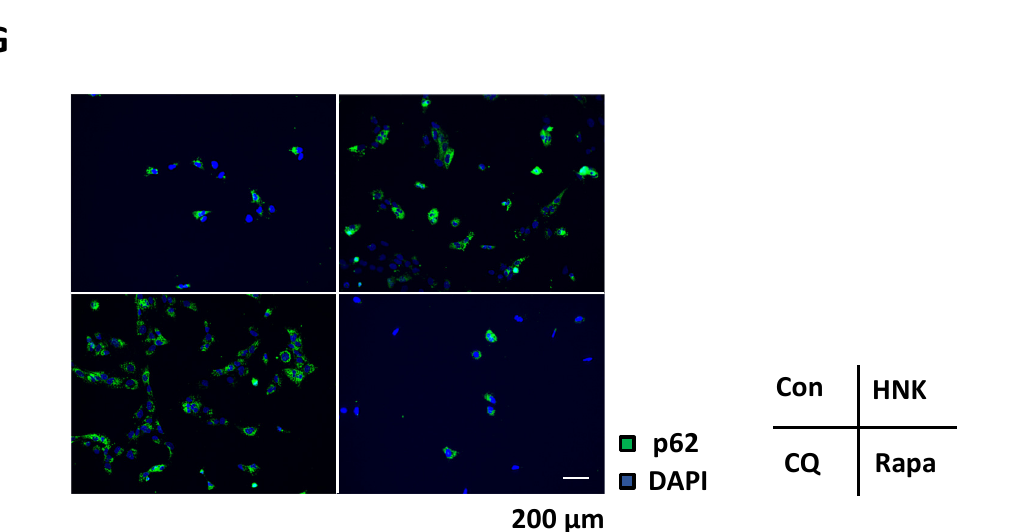
Figure 5. Effects of HNK in suppressing LX-2 activation related to autophagy pathway. ( A – F ) Immunoblot of markers related to autophagy (LC3-I, -II) in LX-2 cells incubated with the noted concentrations of HNK with or without 10 μ M chloroquine phosphate (CQ) or 2.5 μ M rapamycin (Rapa). GAPDH was used as a loading control. Numbers on the right indicate the noted molecular weights (kDa). The ratio of LC3-II to LC3-I (LC3-II/LC3-I) in each group is shown as fold change with reference to the vehicle-treated group. ( G ) Immunofluorescence analysis (IF) of p62 protein (green) in LX-2 cells counterstained with DAPI (blue) after 12 h incubations with DMSO (negative control), 20 μ M HNK, 10 μ M CQ (without HNK), or 2.5 μ M Rapa (without HNK). Scale bars represent 200 μ m.